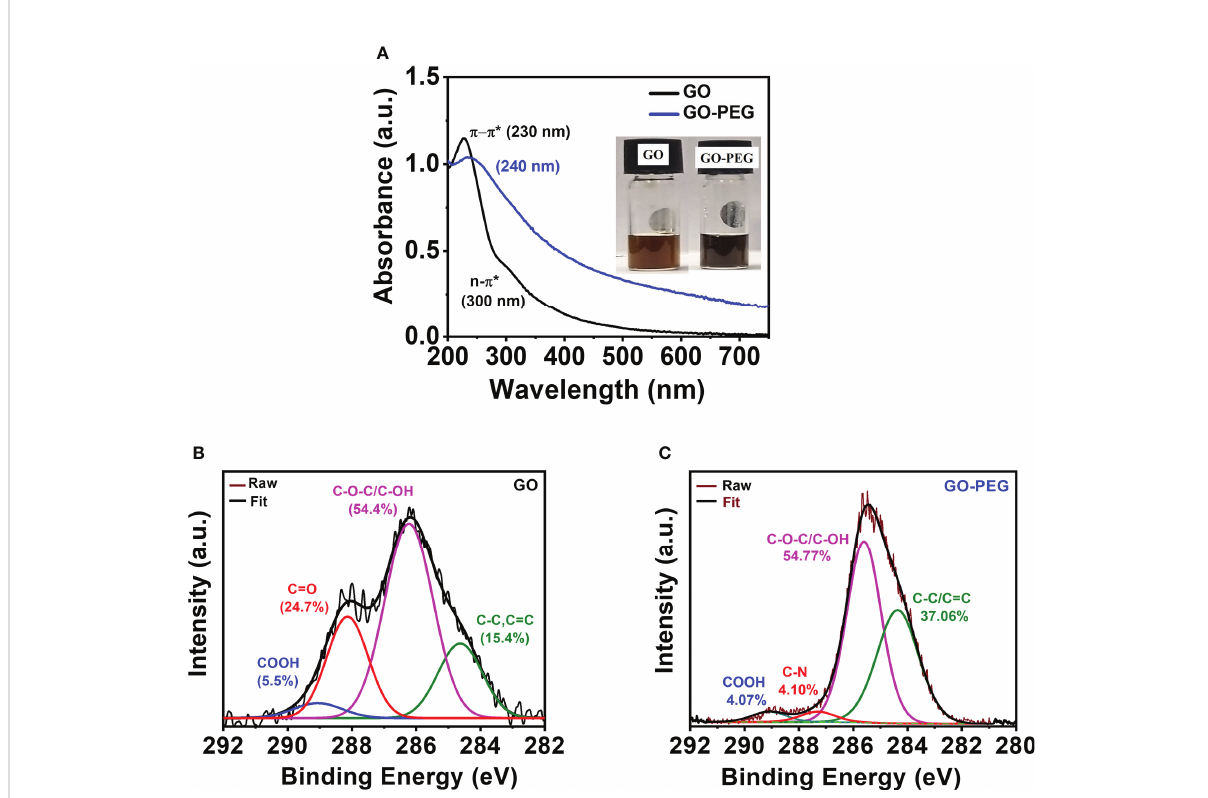
FIGURE 3 PEGylation of GO. (A, B) UV – visible spectra (inset shows digital images of the nanoparticle aqueous dispersions at a concentration of 0.5 mg/ ml). XPS high-resolution deconvoluted spectra of C1s of (B) GO and (C)